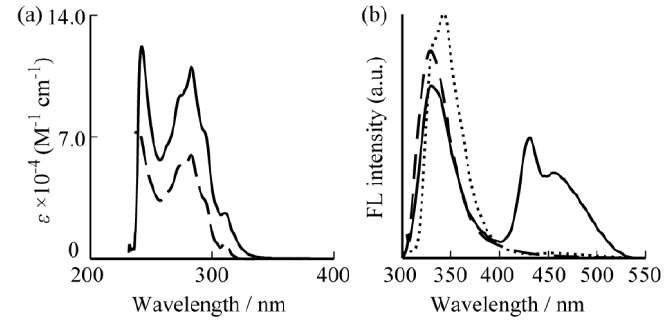
Figure 1. ( a ) UV-vis and ( b ) fluorescence spectra of G1 (dashed line) and G2 (solid line) dendrimers and vitamin K4 (dotted line) in CHCl